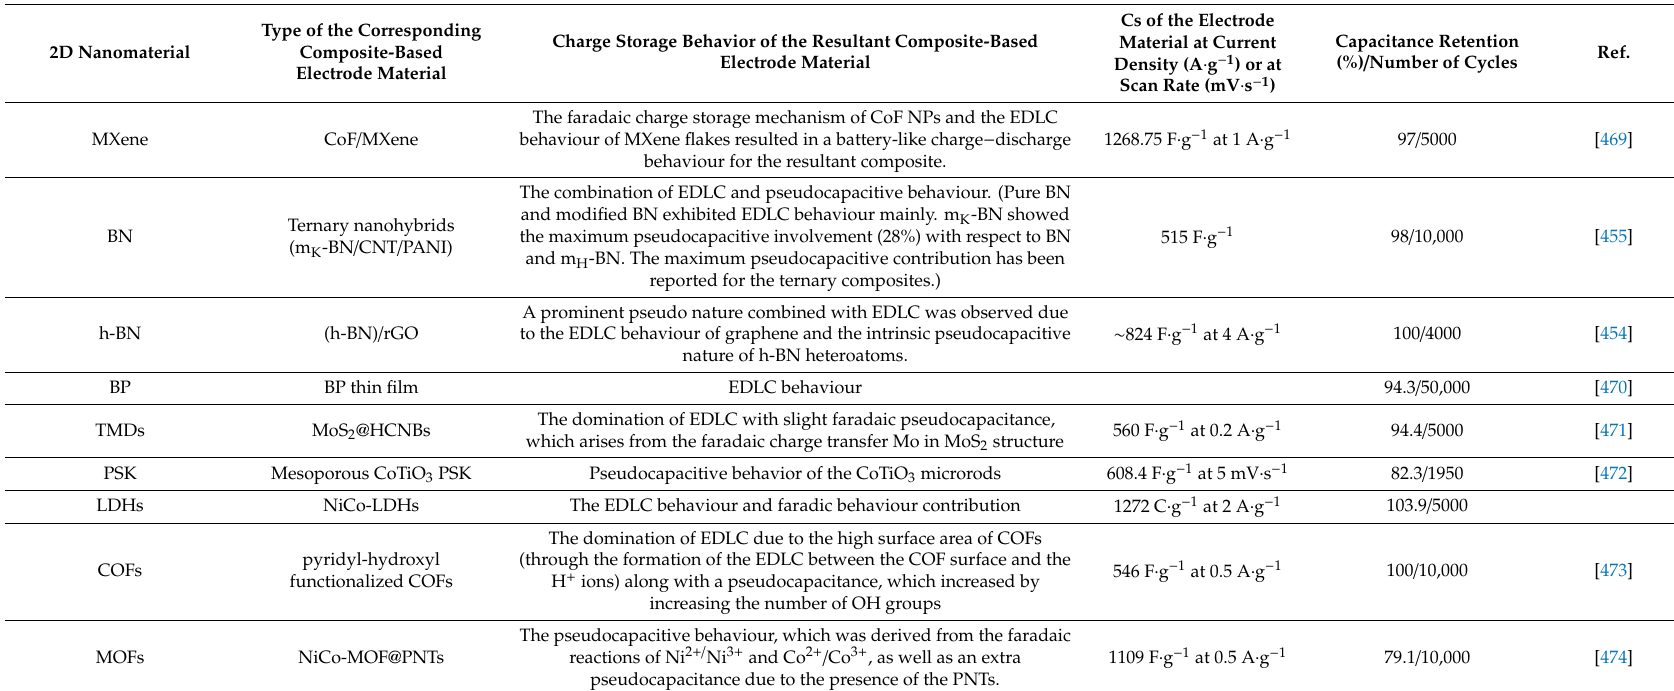
Table 2. A comparison of various 2D nanomaterials utilized as the electrode in SC